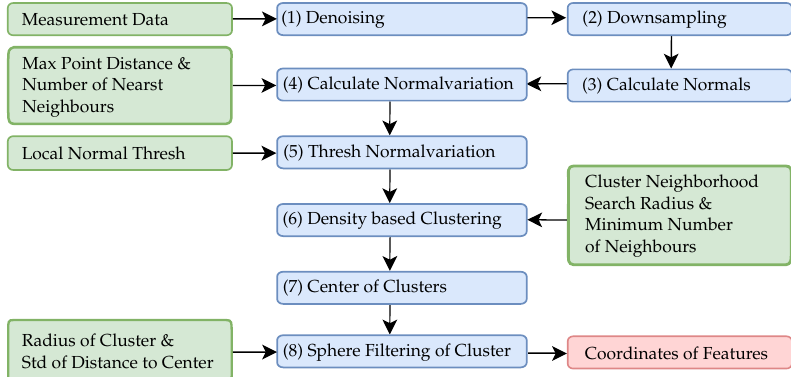
Figure 5. Workflow of the film-cooling hole